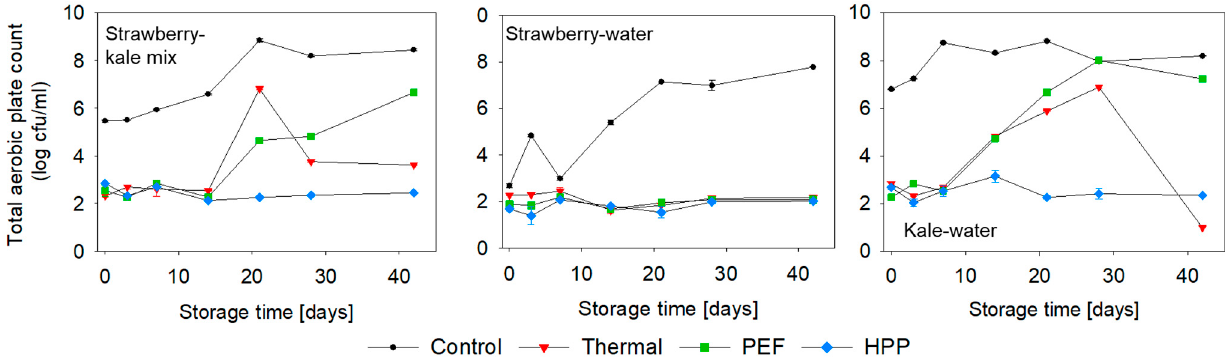
Figure 1. Total aerobic plate count (log CFU/mL) during refrigerated storage at 4 °C (n = 2). PEF: pulsed electric fields and HPP: high-pressure processing.